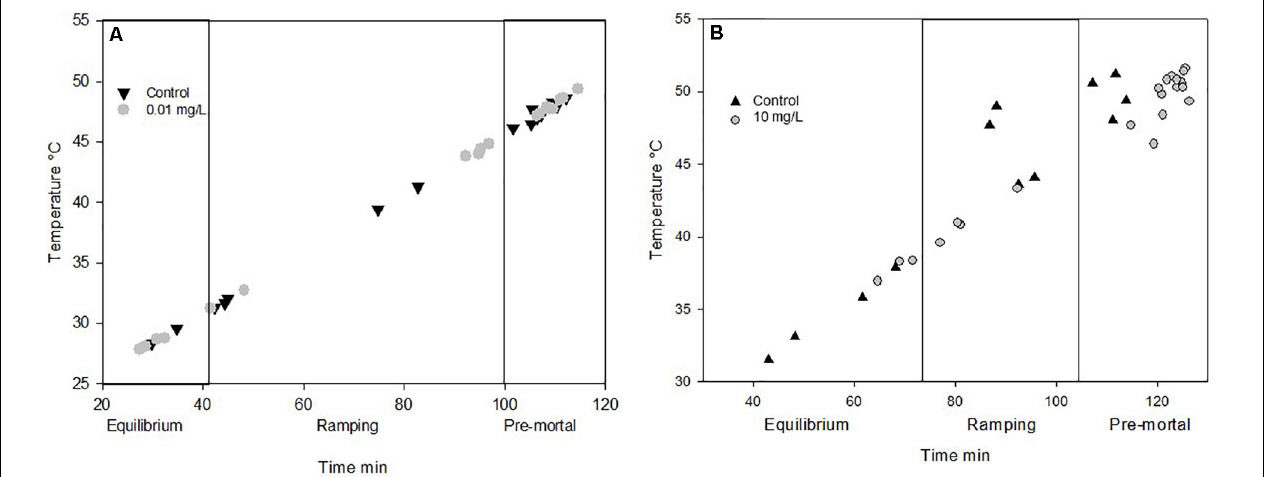
FIGURE 4 | (A) Different stress phases in Insects during ramping phases of (A) Spinetoram experiment and (B) Azadirachtin experiment. Points mark the end of the phase of each individual. Equilibrium marks the no stress phase. In the ramping phase the insects starts to respire in a higher frequency with raising temperature. At the pre mortal phase the insect is about to